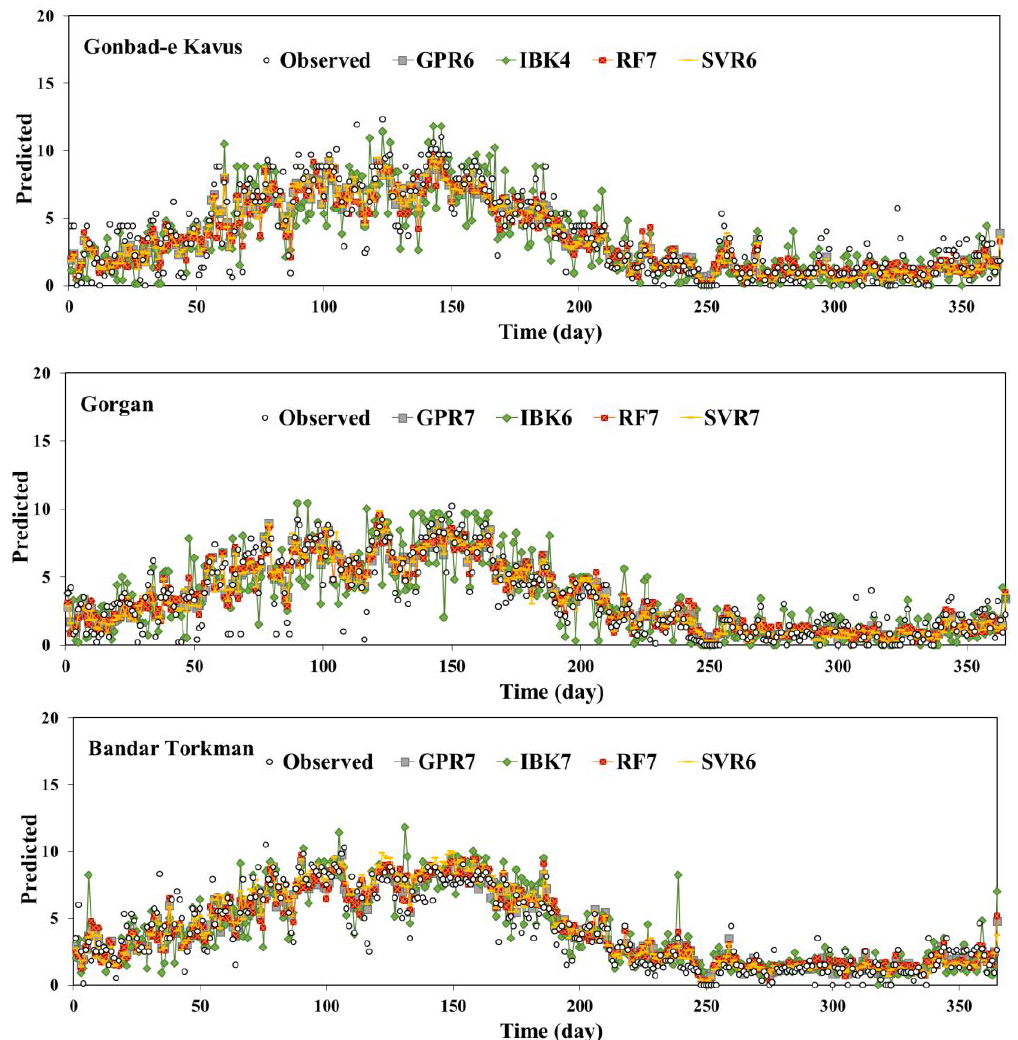
Figure 2. Time variations of observed and predicted PE values using the most accurate models.